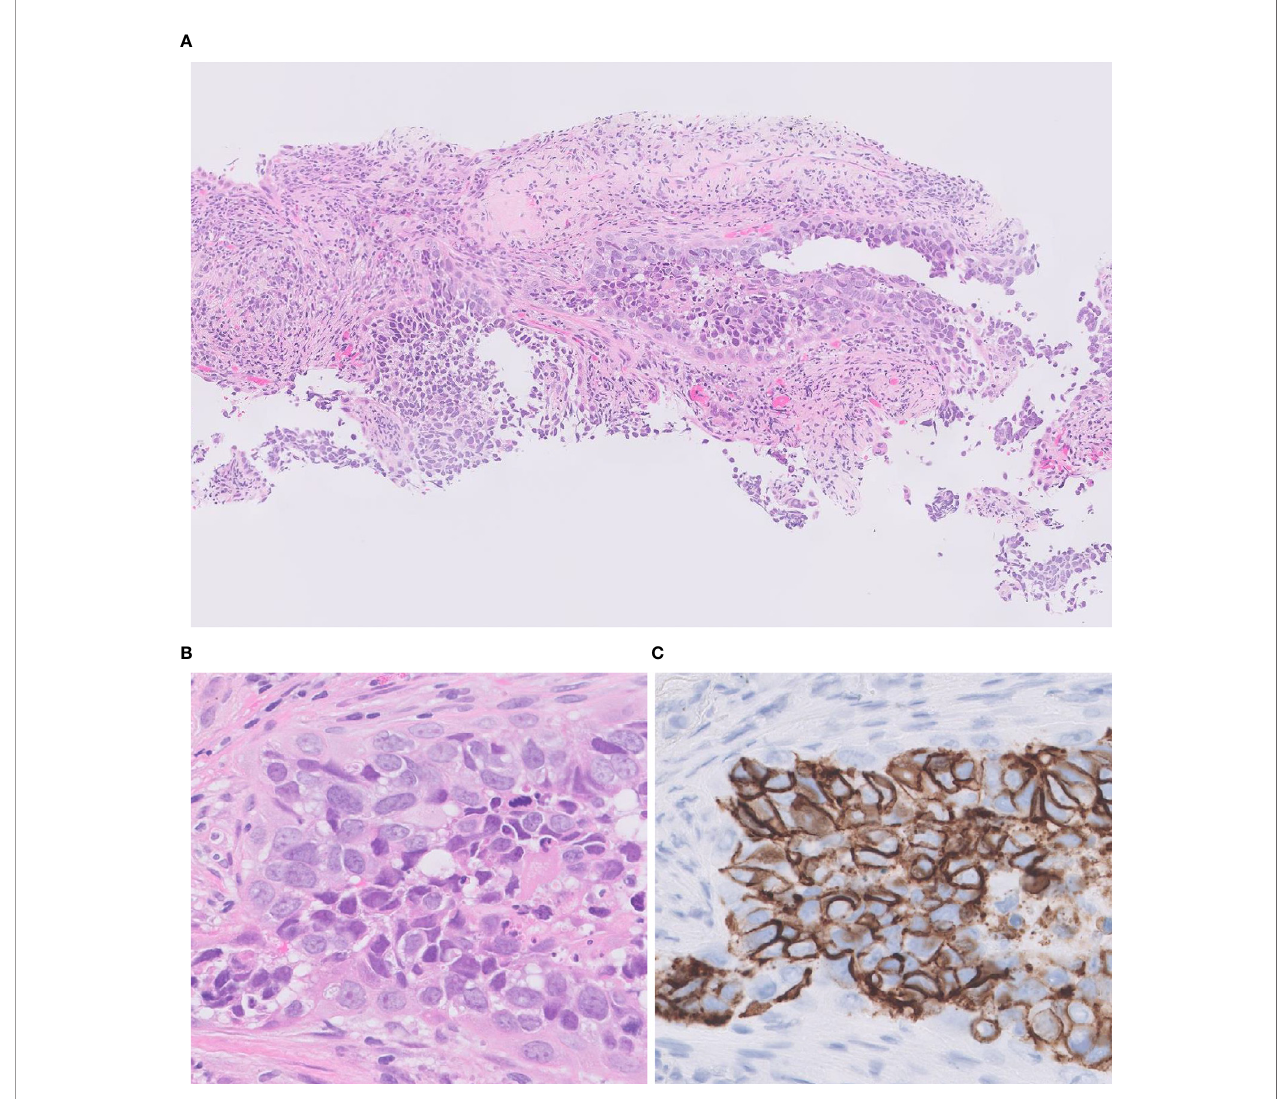
FIGURE 6 | Transbronchial lung biopsy of LCNEC. A small-sized specimen featuring tumor cells with abundant eosinophilic cytoplasm, coarsely granular chromatin, and prominent nucleoli. H&E (A, B) ; CD 56 (C) Magni fi cation: ×10 (A) ; ×40 (B, C)